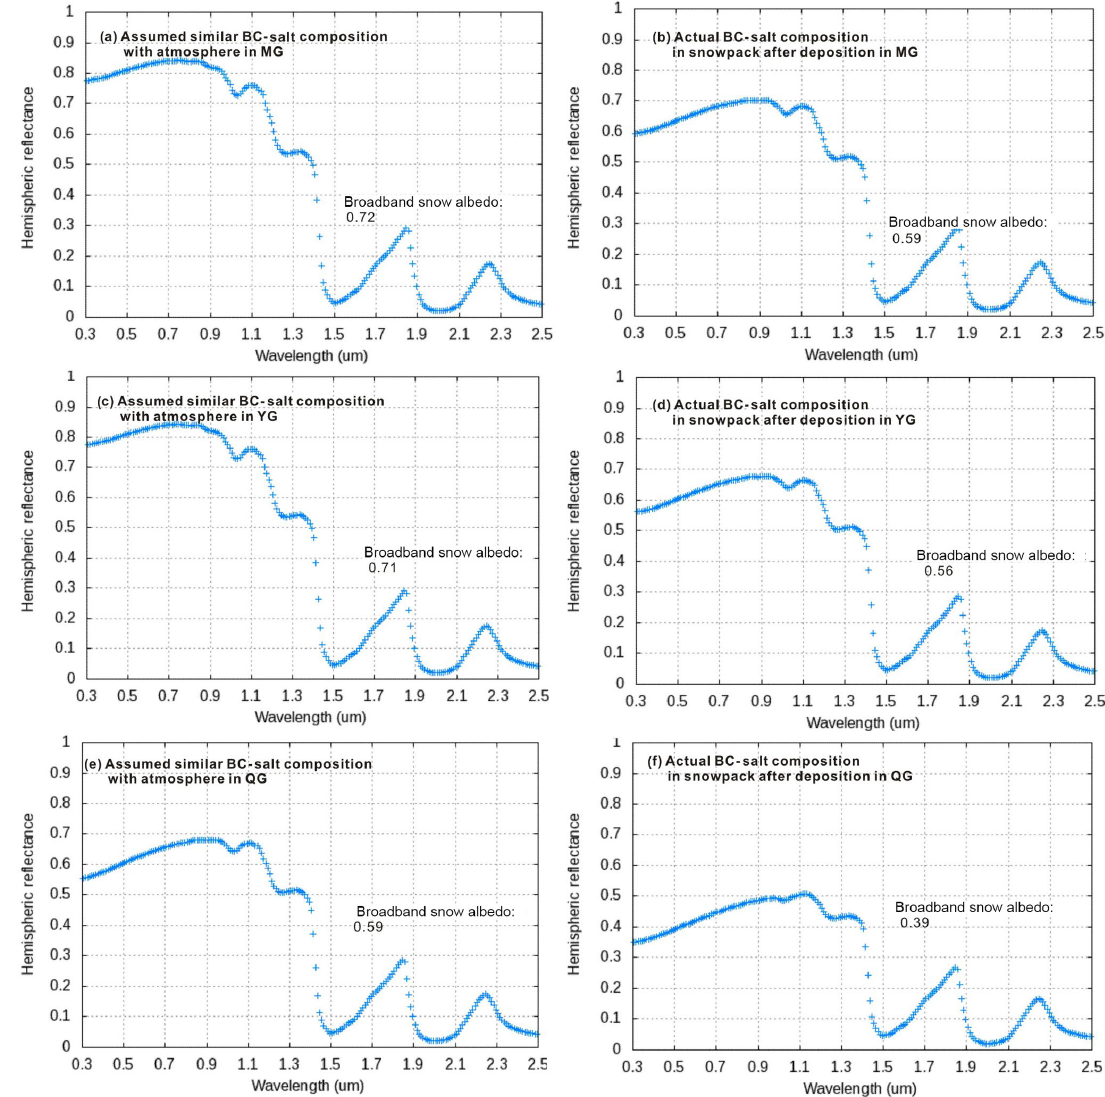
Figure 11. Evaluation of snow albedo change of BC-salt-coating change in the snowpack compared with atmosphere using SNICAR model simulation in the MG (a, b) , YG (c, d) , QG (e, f) , which shows the largely decreased albedo of snow surface impurities in snowpack compared to that of the atmosphere, implying markedly enhanced radiative forcing in the snowpack surface